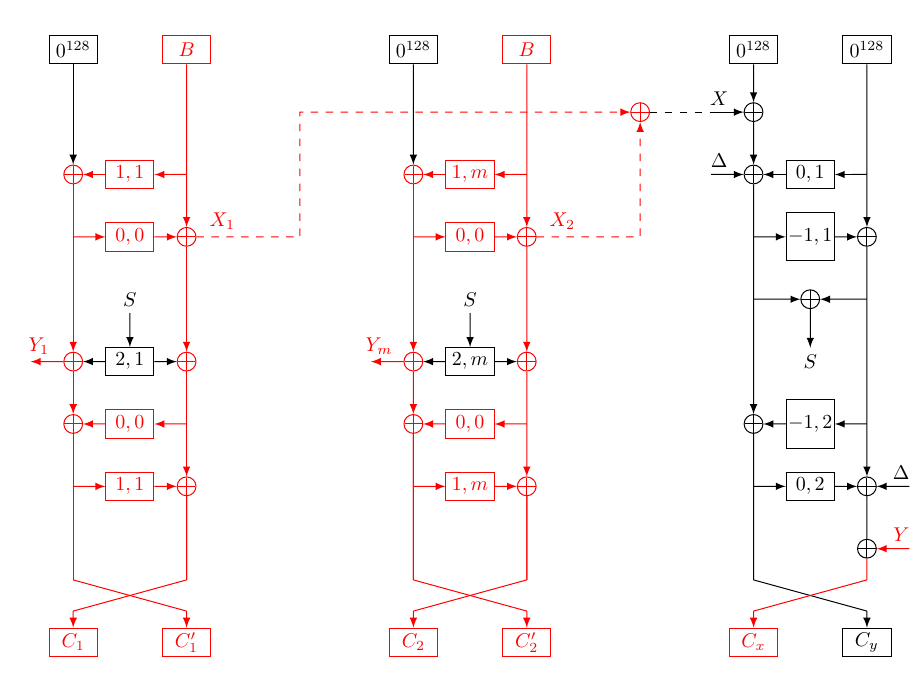
Figure 2: Difference propagation in the birthday attack to retrieve I